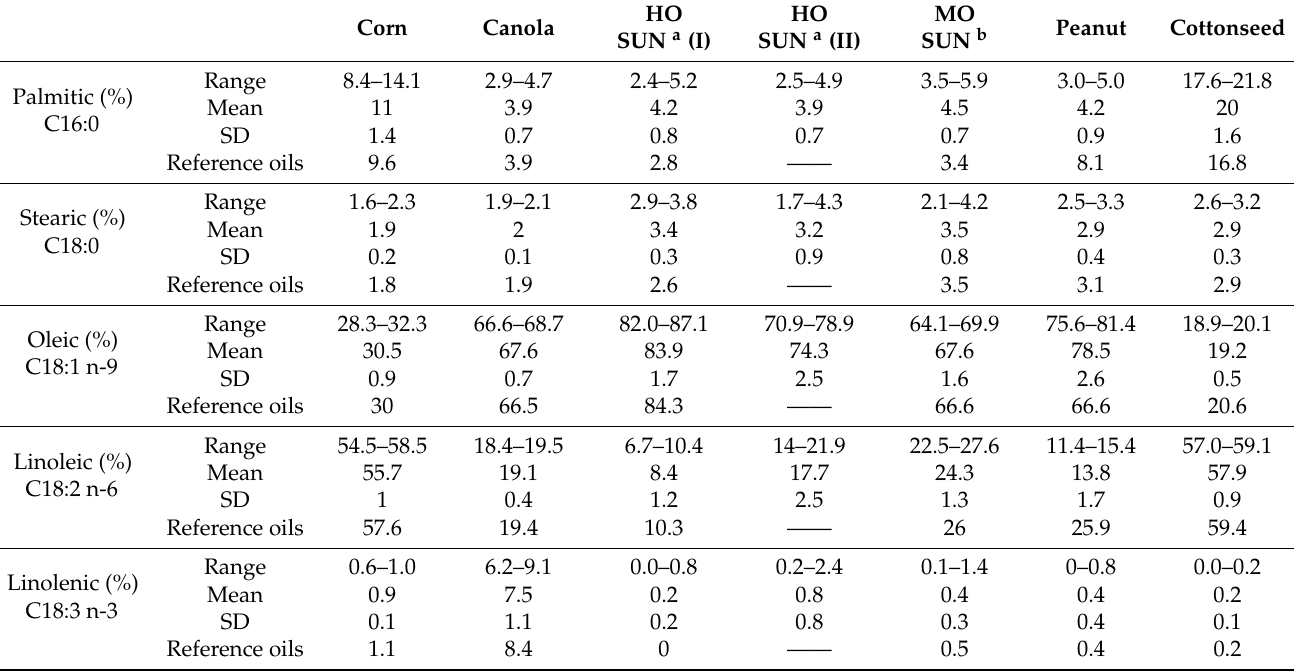
Table 1. Fatty acid composition summary of oil from potato chip samples and oil references using gas chromatograph flame ionization detector (GC-FID)